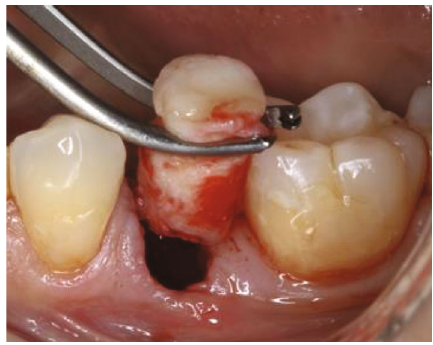
Figure 3: Fitting of the graft.